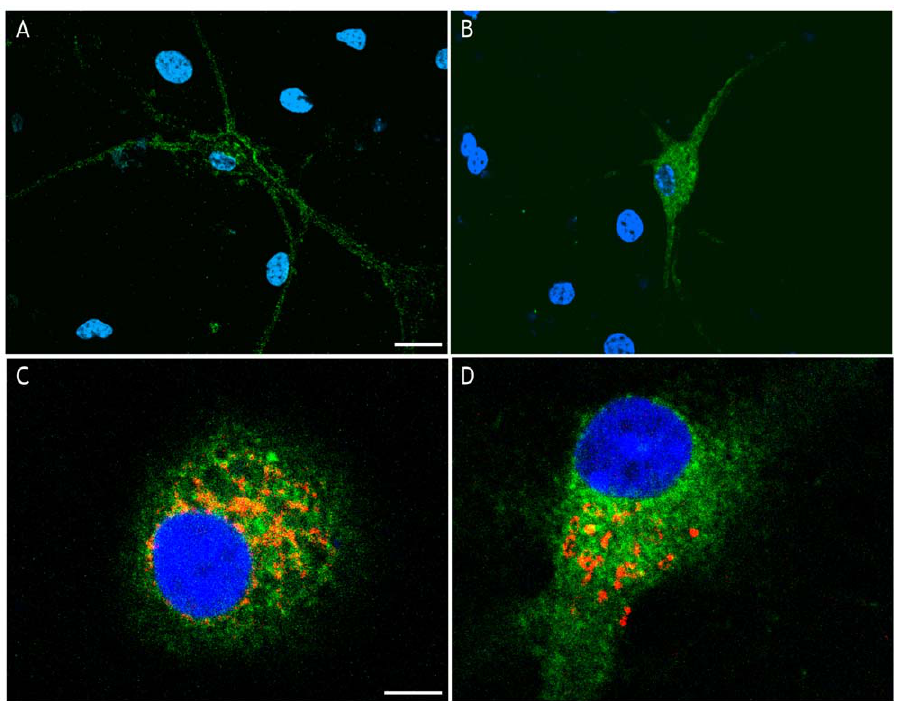
Figure 3. Untranslocated PrP shows cytosolic localization. Hippocampal neurons from C57BL/6J mice were transfected with a plasmid encoding PrP-EGFP (green). Twelve days after transfection cells were exposed to the vehicle (A) or treated with 10 m M CAM741 for 24 h plus 5 m M MG132 during the last 6 h (B–D). Cells were then fixed and reacted with DAPI (blue) to stain the nuclei. Cells in C and D were also immunostained with an anti-PDI or anti-golgin antibody (red) to visualize the ER and Golgi, respectively. Scale bar =10 m m in A (also applicable to B), and 5 m m in C (also applicable to D).